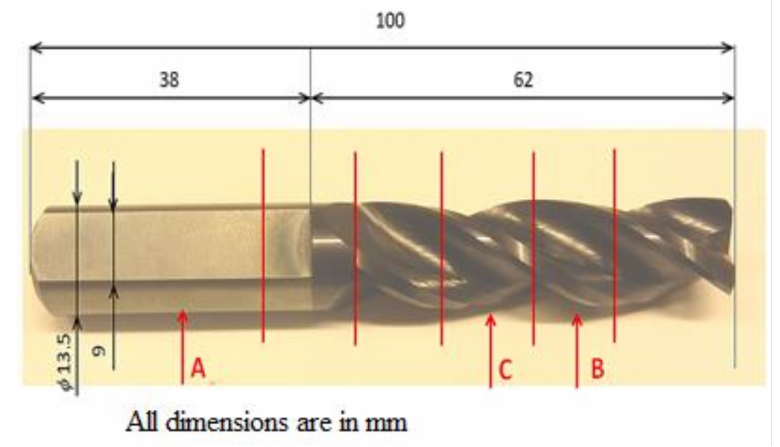
Figure 1. The whole body of the milling drill with a TiAlN coating applied to its working part with the determination of the places of selection for analyses (author source).